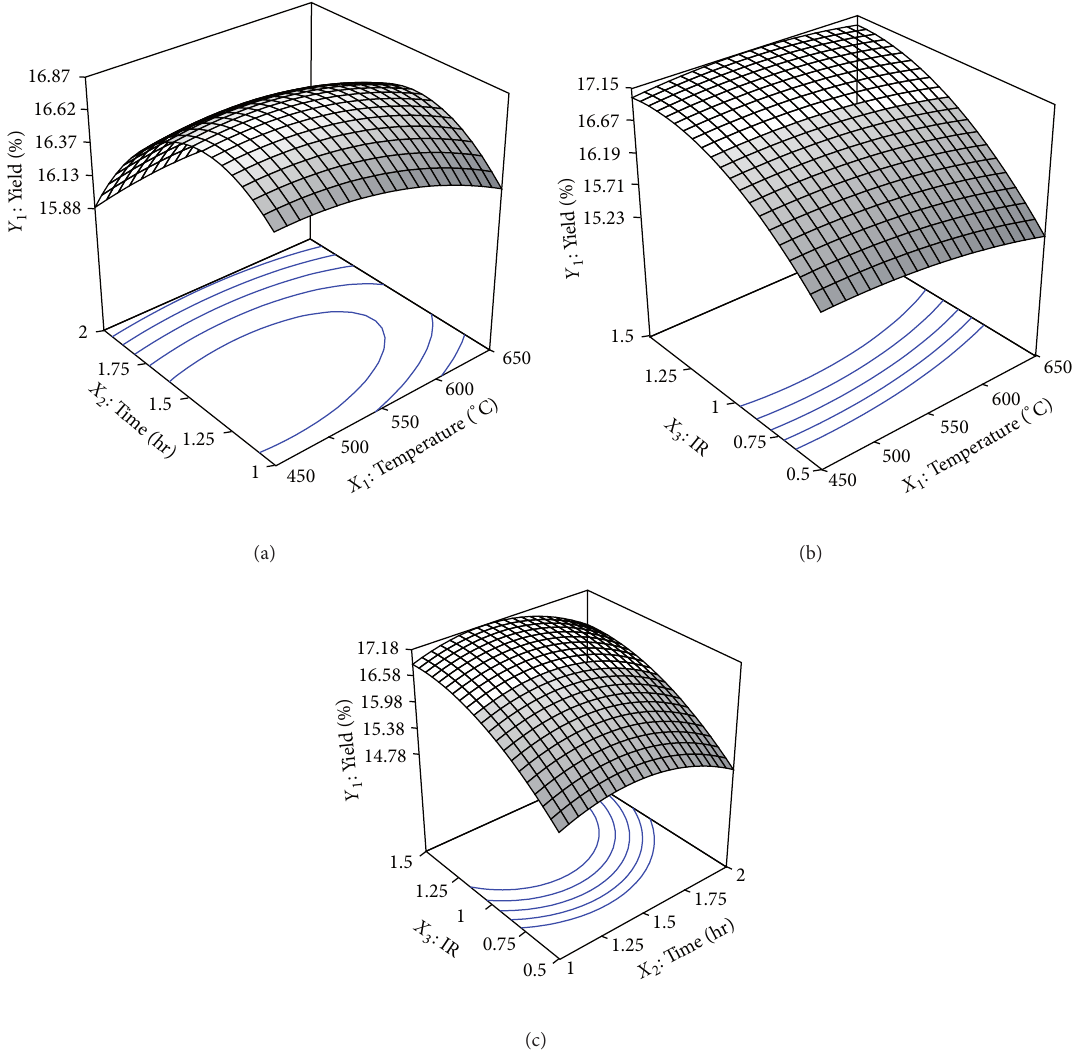
F 1: ree-dimensional response on the yield of BPAC, (a) the variables activation temperature and activation time, (b) the variables activation temperature and IR, and (c) activation time and